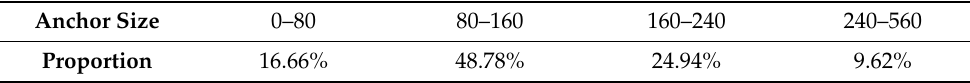
Table 2. Comparison of the results of different anchor size settings. Anchor